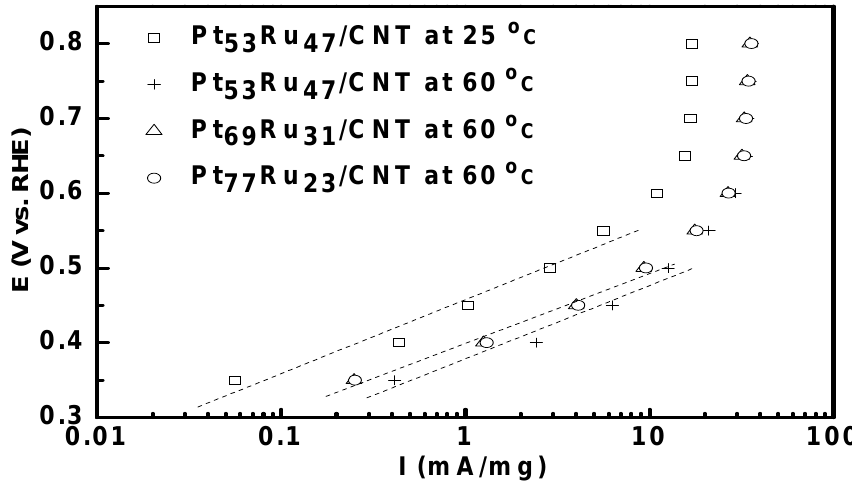
Figure 2. Tafel plots for methanol electro-oxidation on the PtRu/CNT